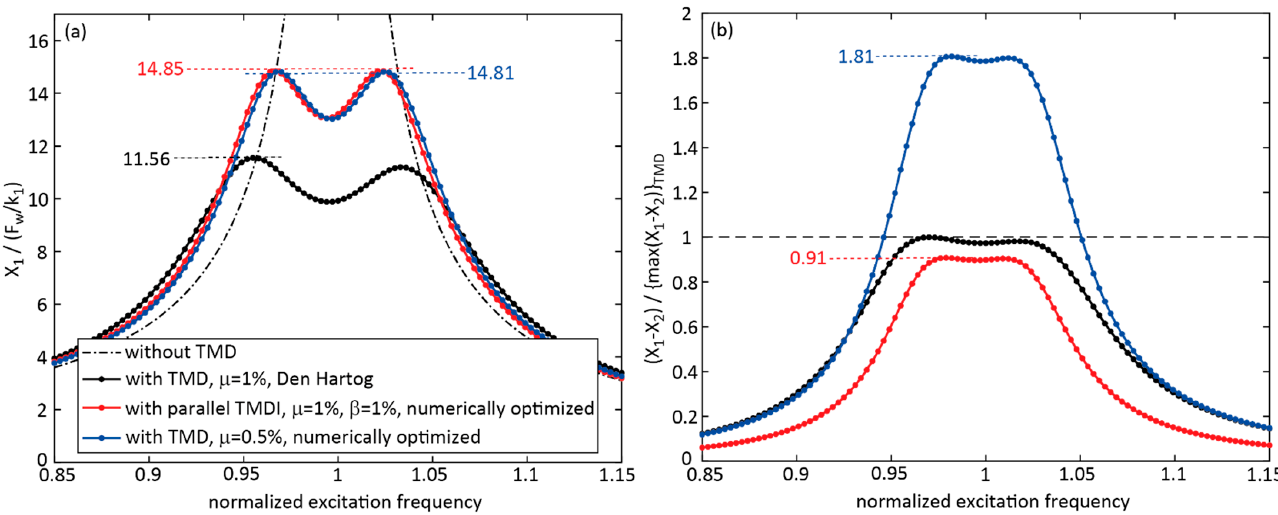
Figure 6. Performances of TMDI with inerter in parallel to stiffness and viscous damper ( µ = 1%, β = 1%, numerically optimized parameters), TMD ( µ = 1%, Den Hartog parameters) and TMD ( µ = 0.5%, numerically optimized parameters) for harmonic excitation: ( a ) primary structure normalized displacement response and ( b ) normalized damper relative motion response.